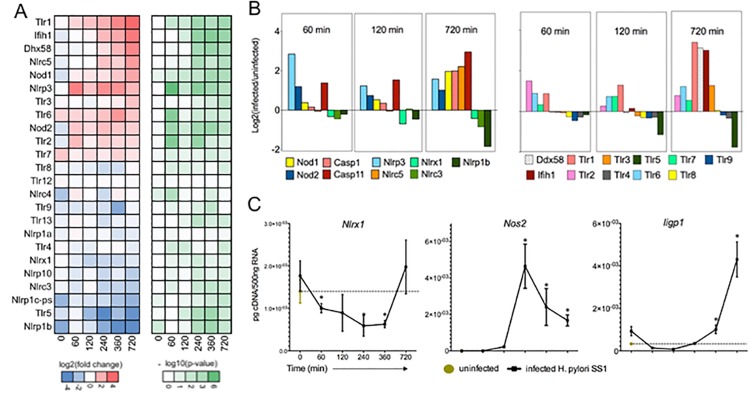
Pattern recognition receptors are differentially regulated by Helicobacter pylori.Genes involved in pathogen detection were extracted from the RNAseq dataset and analyzed at each time point for significance (A; left–expression, right–significance). Expression of effector PRRs conformed to sustained or late waves whereas regulatory molecules were suppressed (B). Dynamic expression of transcripts observed by RNAseq was validated by quantitative real time RT-PCR (C). Transcriptomic data (A,B) are presented as average log2(ratio) whereas validation gene expression is presented as pg cDNA/500ug RNA. Asterisk indicates P-value < 0.05 based on ANOVA.